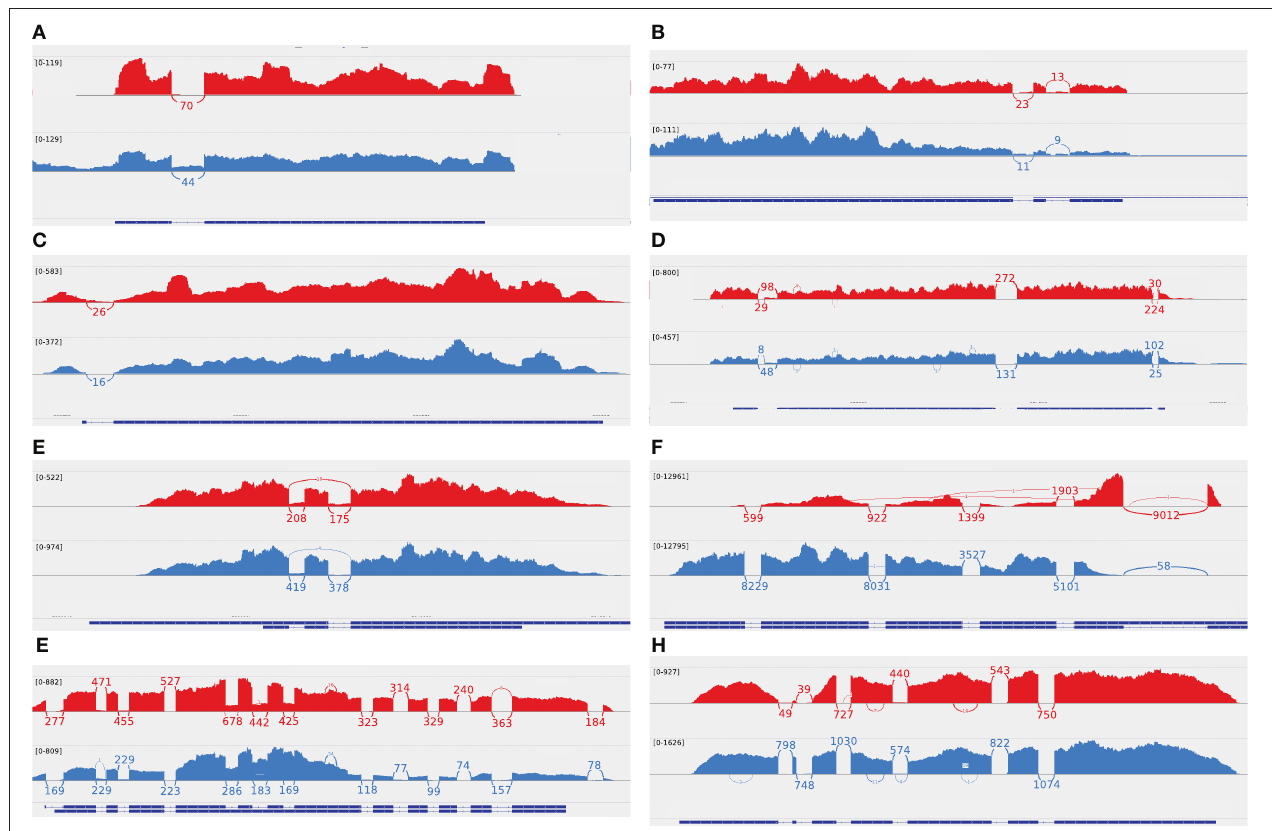
FIGURE 7 | Sashimi plots of selected differentially alternatively spliced genes give information about gene expression (profile of mapped reads) and splice junctions (curved lines). Each plot shows the control (red) and the corresponding treatment (blue). The blue bars on the bottom indicate the exons, and the dotted lines indicate the introns of the corresponding gene. (A) C. albicans SOD3 (manganese-containing superoxide dismutase) is shown during control (red) and oxidative stress (blue), which retains an intron. It appears similar during hyphal growth. (B) C. albicans CAN3 (transmembrane amino acid transporter) is shown during control (red) and treatment with acetic acid (blue). It retains one or two introns during the stress treatment. (C) C. parapsilosis CPAR2_801460 (glutathione transferase activity) is shown during control (red) and in a glucose-rich BMW medium (blue). It retains an intron during the control treatment. (D) A.fumigatus AFUB_001340 (putative nuclear splicing factor) is shown during control (red) and treatment with caspofungin (blue) with alternative 3 ′ or 5 ′ splice sites. (E) A.fumigatus AFUB_043270 (putative C6 transcription factor) is shown during control (red) and reduced oxygen for 15minutes (blue). The portion of intron retention is higher during the control condition. (F) C. neoformans CNAG_06101 (ADP/ATP carrier protein) is shown during control (red) and increased temperature (blue). It retains an intron during the treatment within the 5 ′ UTR. (G) L. corymbifera LCOR_03517.1 (transmembrane protein) is shown during control (red) and hypoxia (blue) with three retained introns. (H) L.